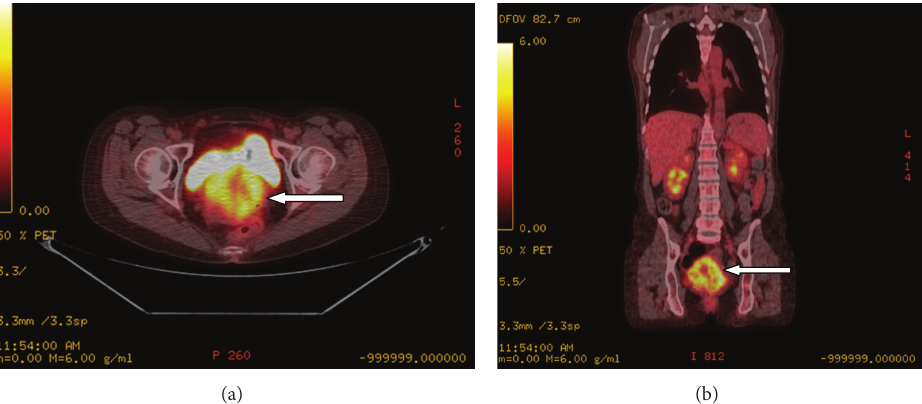
Figure 5: Axial (a) and coronal (b) PET-CT fusion images of the pelvis demonstrate a biopsy-proven lymphomatous 8.4 cm × 5.3 cm mass in the cervix (arrow) with a maximum SUV of 20.7.